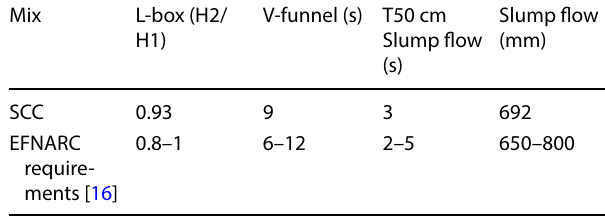
Table 3 Results of fresh SCC tests